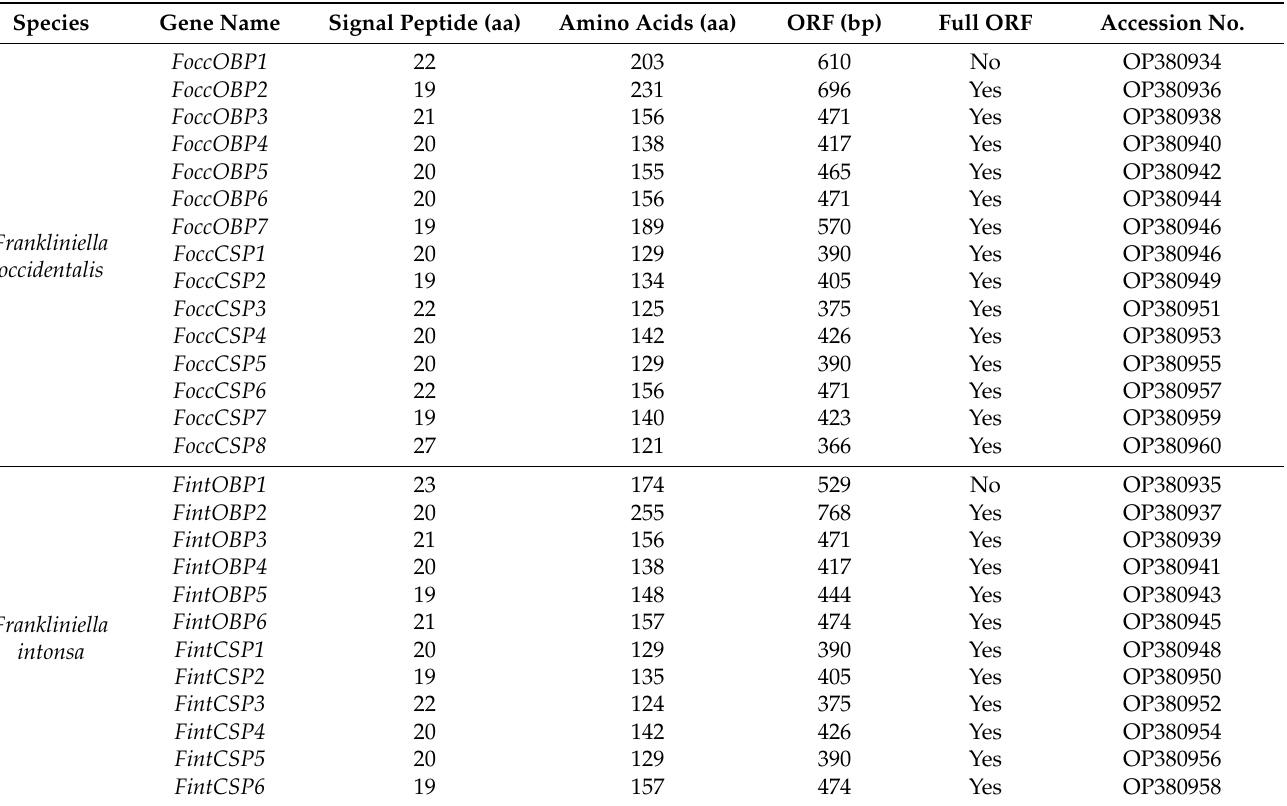
(Table 1). Among the 13 putative OBPs, 7 were OBP genes in F. occidentalis (FoccOBP1~7), and 6 were OBP genes in F. intonsa (FintOBP1~6). Among the 7 OBPs in F. occidentalis , FoccOBP1 (KM527948.1), FoccOBP2 (KM527950.1), and FoccOBP4 (JF937664.1) have been reported previously. FoccOBP2 and FintOBP2 belong to the Plus-C subfamily, while FoccOBP5 and FintOBP5 belong to the Minus-C subfamily. The remaining nine genes were classical OBPs. The alignment of candidate OBPs revealed that six orthologous pairs shared high amino acid identities ( ≥ 76.72%) between F. occidentalis and F. intonsa , respectively (Table 2; Figure 3A). Table 1. List of odorant-binding proteins (OBPs) and chemosensory proteins (CSPs) in Frankliniella occidentalis and Frankliniella intonsa .